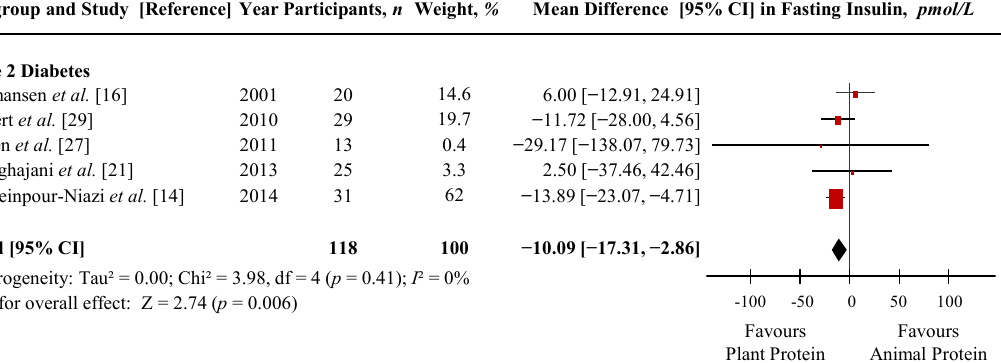
Figure 4. Forest plot of randomized controlled trials investigating the effect of replacing sources of animal with plant protein in individuals with diabetes on fasting insulin. Pooled effect estimates for each subgroup and overall effect are represented by the diamonds. Data are expressed as weighted mean differences with 95% confidence intervals (CIs), using the generic inverse-variance method with random effects models. Paired analyses were applied to all crossover trials. Inter-study heterogeneity was tested by the Cochran Q-statistic and quantified by I 2 at a significance level of p < 0.10; d f , degrees of freedom.